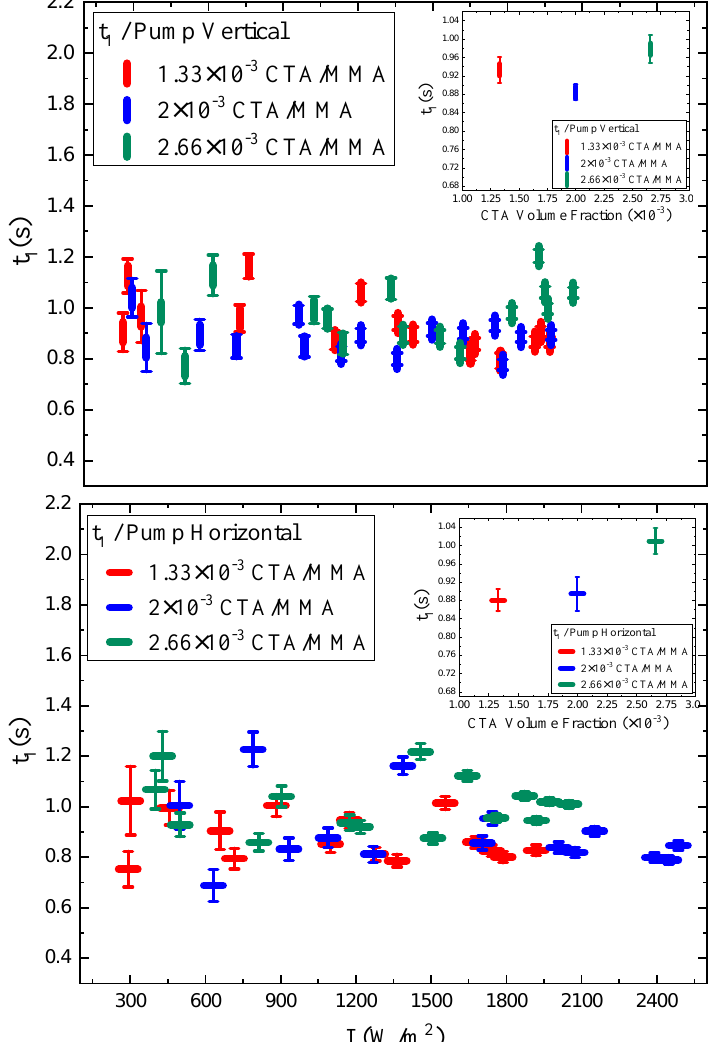
Figure 13. Time constant t 1 (light on) as a function of intensity for different CTA volume fractions for a vertically and horizontally polarized pump. The insets show the time constants as a function of CTA volume fraction averaged over all